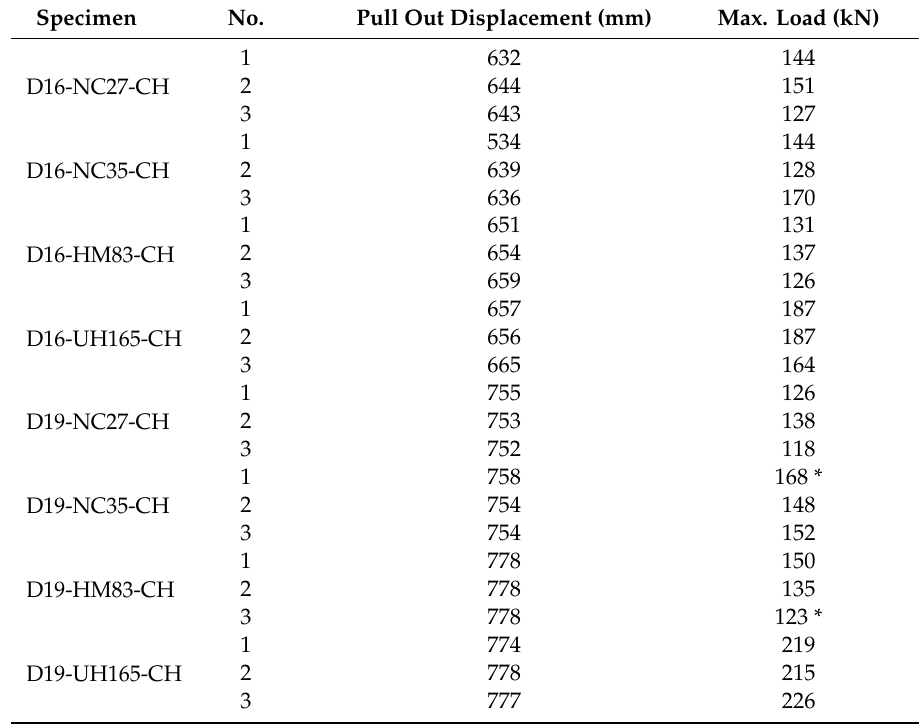
Figure 17. Pull-out test results of 19 mm GFRP rebars (normal concrete, mortar, UHPC). Table 6. Test results of the pull-out test (D16 and D19 headed GFRP rebars, normal concrete, mortar,